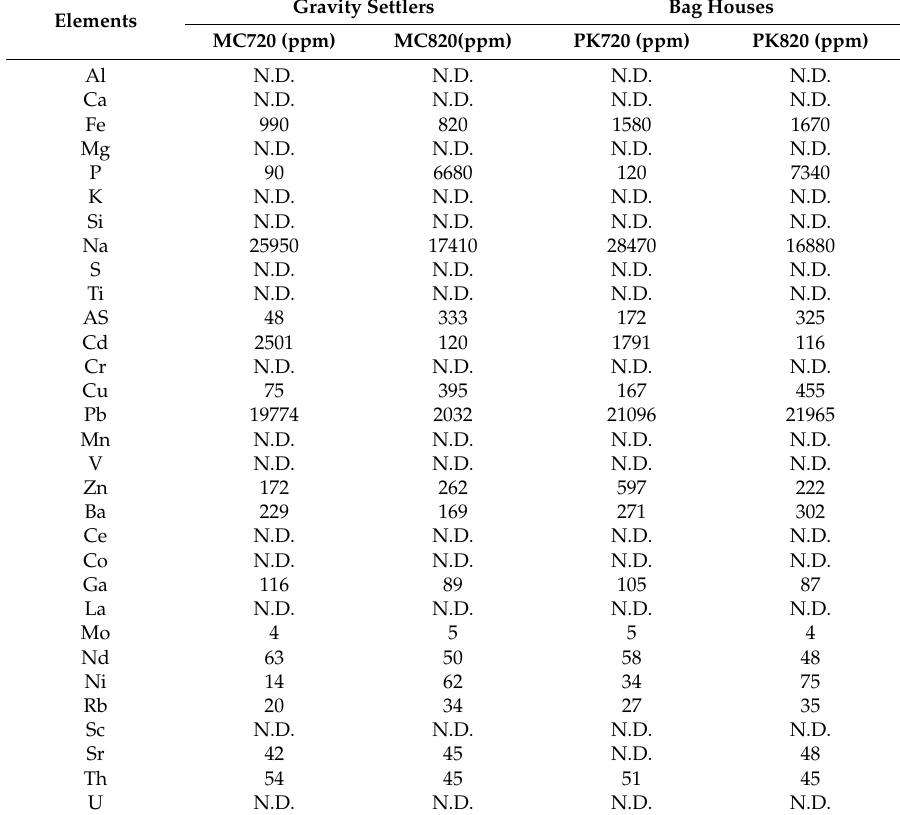
Table 2. Heavy metal concentrations in the dust from gravity settlers and from bag houses. N.D. stands for